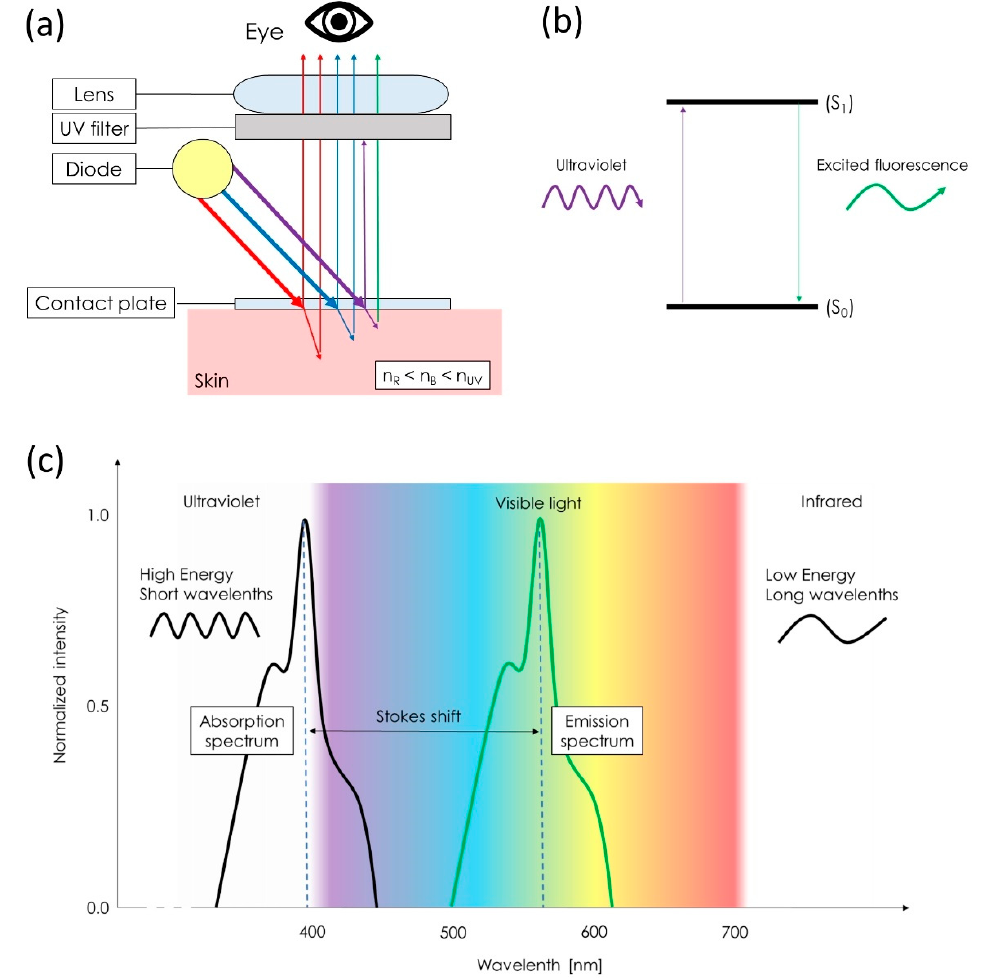
Figure 1. Basics of multispectral and ultraviolet-induced fluorescence dermatoscopy: Each diode of a dermatoscope emits light characterized by particular energy and wavelength that impacts its refraction in the skin, its penetration, absorption by the chromophores, scattering, and reflection. Reflected light is recorded by the observer. ( a ) Reflected UV light is blocked by the UV filter that allows the passage of the visible spectrum of light. ( b ) UV-excited skin chromophore moves from the ground vibrational level (S 0 ) to the higher vibrational level (S 1 ). Moving back to the ground vibrational level is accompanied by the emission of new photon (usually of a longer wavelength, so belonging to the visible spectrum of light). ( c ) This photon is responsible for the UV-excited fluorescence (Stokes shift phenomenon) seen by the